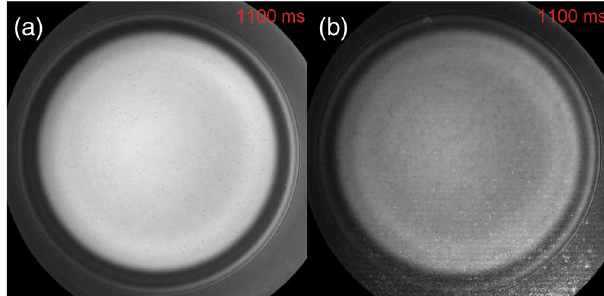
FIG. 12. Tracer particles and interference fringes for wave- length (a) 434 nm and (b) 546 nm. The tiny dark spots which appear in both channels are the tracer particles in liquid film, while the bright spots which only appear in (b) are the tracer particles in